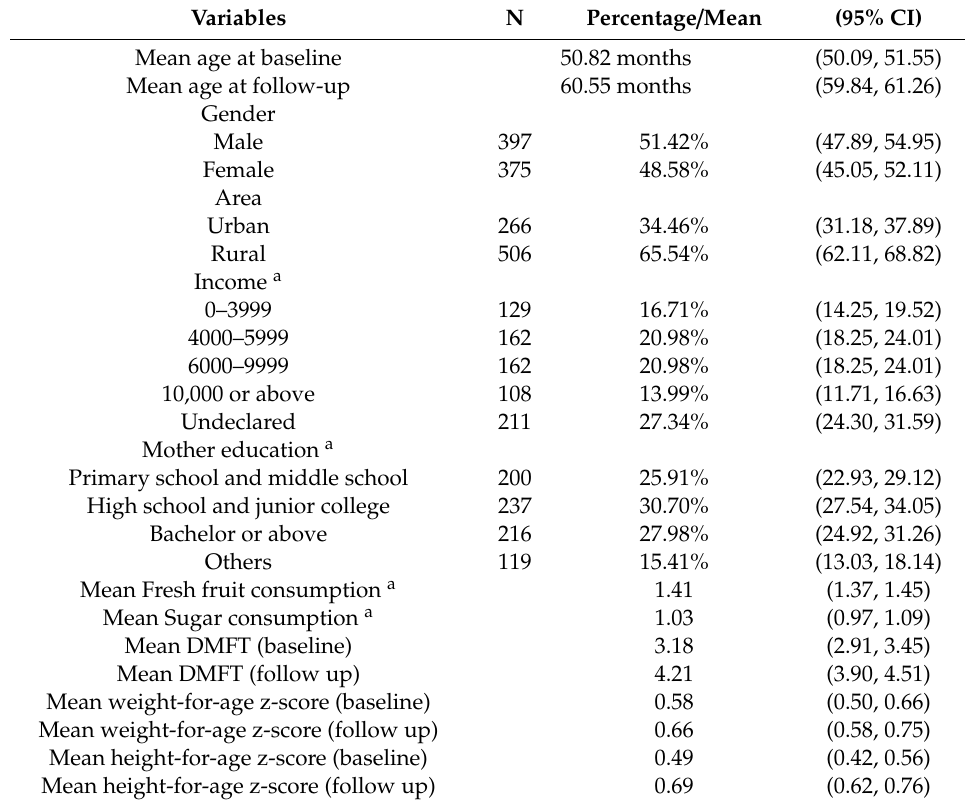
Table 1. Description of all variables used in the analysis ( n = 772).